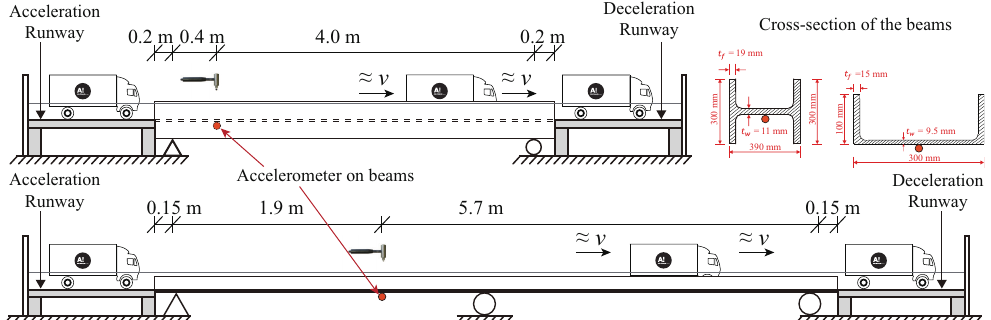
Figure 6. Illustration of beams.